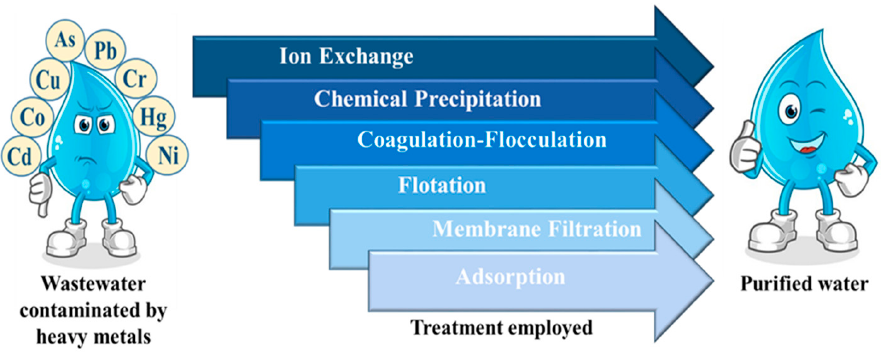
Figure 2. Wastewater recycling